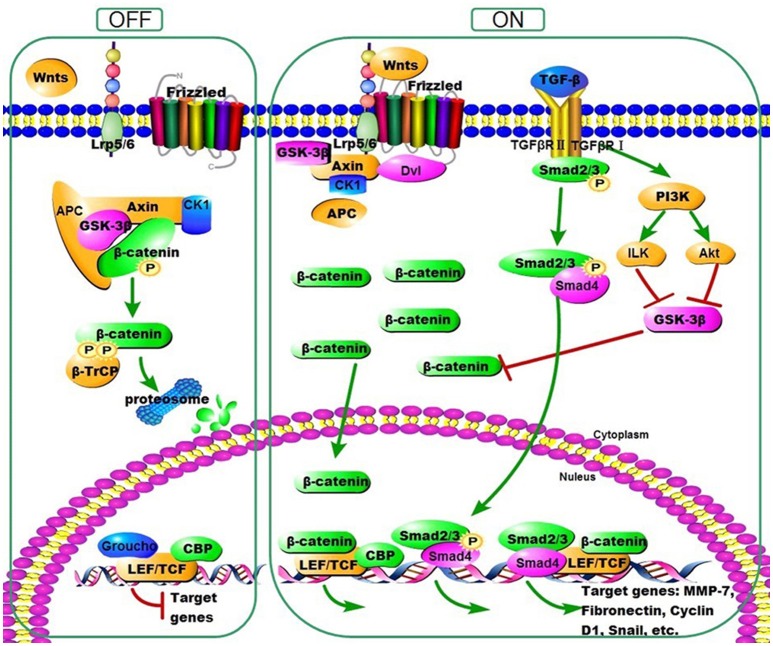
Overview of Wnt/β-Catenin Signaling. Without Wnt ligands, cytoplasmic β-catenin is phosphorylated by a destruction complex. Phosphorylated β-catenin is then ubiquitinated and destructed by the proteasome ultimately. Once activated, Wnt proteins bind to their receptors and induce a series of downstream signaling events which lead to the disassembly of the destruction complex, resulting in dephosphorylation of β-catenin. Accumulated β-catenin then translocates into the nucleus, where they bind to T cell factor (TCF)/Lymphoid enhancer-binding factor (LEF) to stimulate the transcription of Wnt target genes, including fibrosis-related gene expression, such as Fibronectin, Matrix Metallo Proteinases-7 (MMP-7), Twist, and Snail. In addition, Wnt/β-Catenin and TGF-β signaling converge at the promoter, where Smads, β-Catenin, and LEF/TCF form a complex to coregulate specific genes expression. β-catenin is further stabilized in the cytoplasm by the action of TGF-β to signal through phosphatidyl inositol 3-kinase (PI3K).